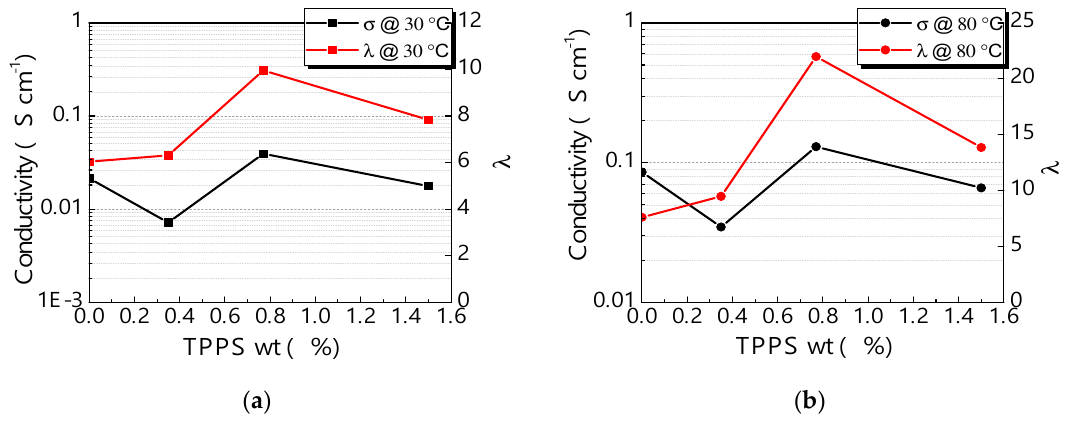
Figure 5. Proton conductivity and λ as a function of porphyrin loading ( a ) at 30 °C, and ( b ) at 80 °C.